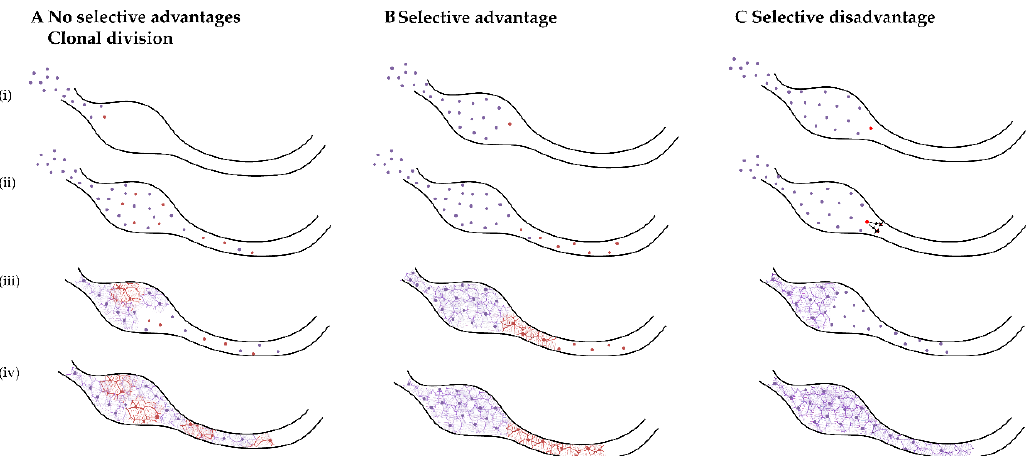
Figure 3. Proposed models of somatic mutations leading to HSCR. Each model shows four developmental stages, from initial ENCC migration into the gut tube (i), further migration and proliferation (ii), initial formation of ganglia (iii), to final colonization and ganglia formation (iv). ( A ) In the non-selective clonal growth and division model, the variant brings no competitive advantage or disadvantage, during migration or proliferation. However, this may lead to decreased differentiation or maturation capacity, for example. ( B ) In the selective advantage model, the variant confers a proliferative or migratory advantage to the cells, allowing them to out-compete the wild-type cells. However, due to early differentiation, altered subtype specification or inability to follow extracellular signals, the cells are unable to reach the distal portion of gut. ( C ) In the selective disadvantage model, the variant affects migration of ENS precursors, or the viability of the cells. As a consequence, the speed of the migratory wavefront is affected, leading to failure of ENCCs to colonize the distal colon. Apoptosis can also occur at some stage of migration or differentiation, resulting in decreased total cell count, that is insufficient to fully colonize the length of the gut tube. This is the most likely model that would result in a HSCR phenotype. Purple dots represent ENCCs with “normal” genotype; red dots represent ENCCs that have acquired a somatic variant.